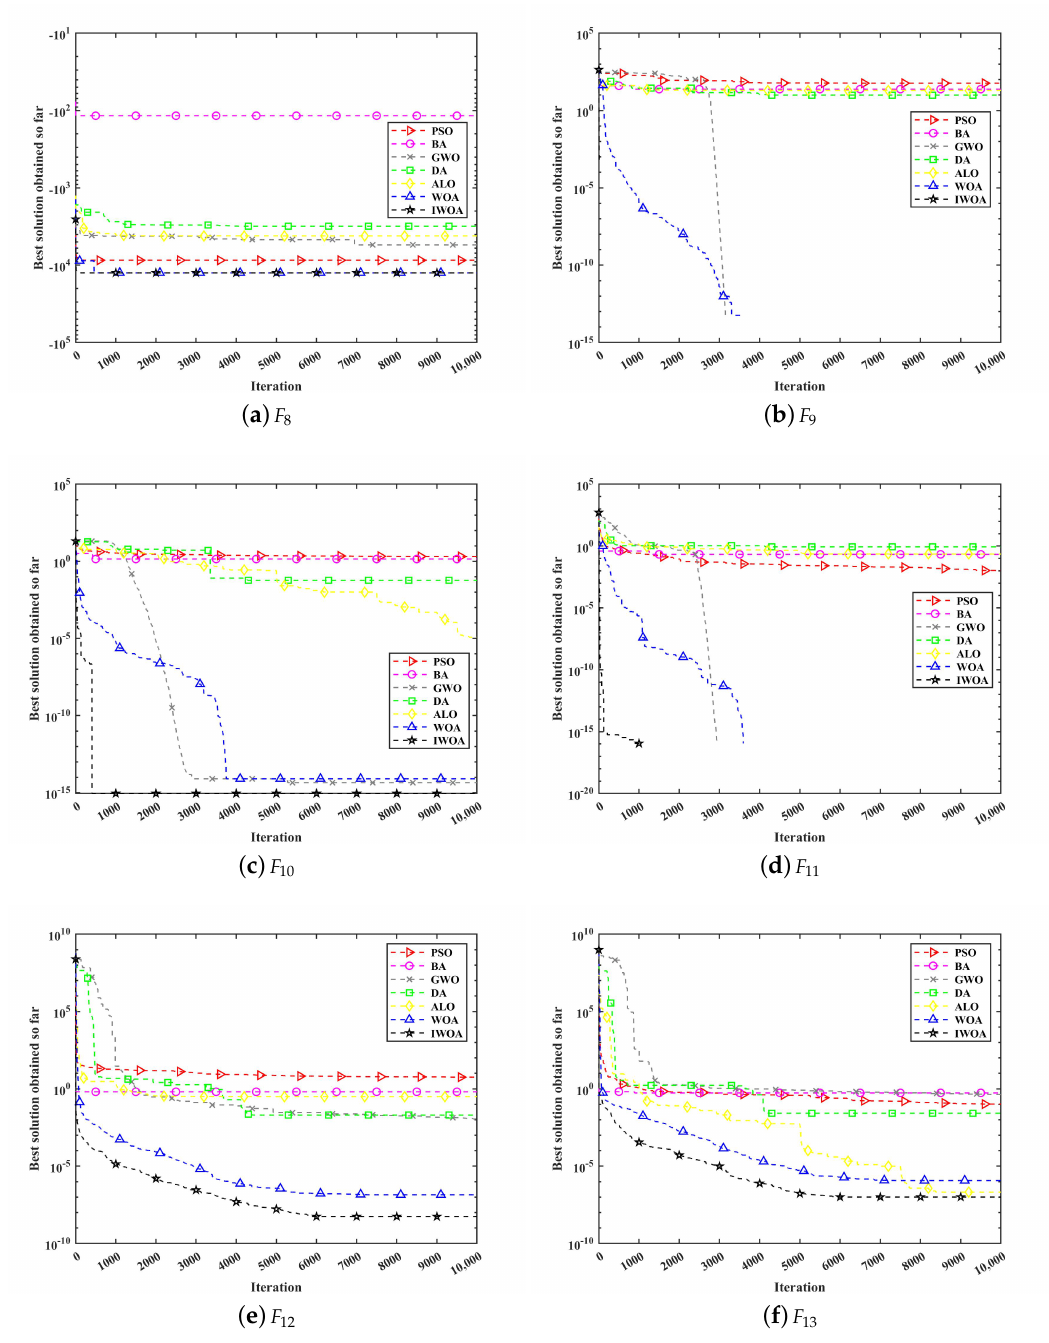
Figure 8. Different algorithms solve F 8 ∼ F 13 multi-modal test functions, and the solution value changes with the number of